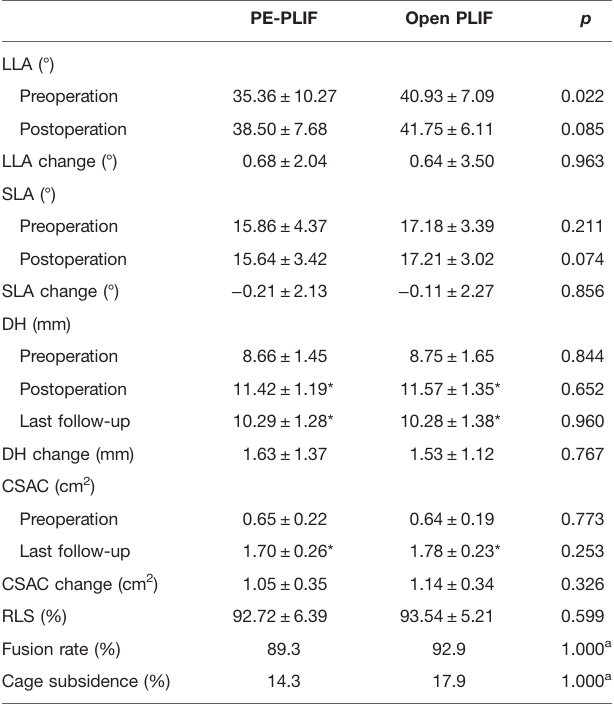
TABLE 3 | The radiographic outcomes in the PE-PLIF and open PLIF